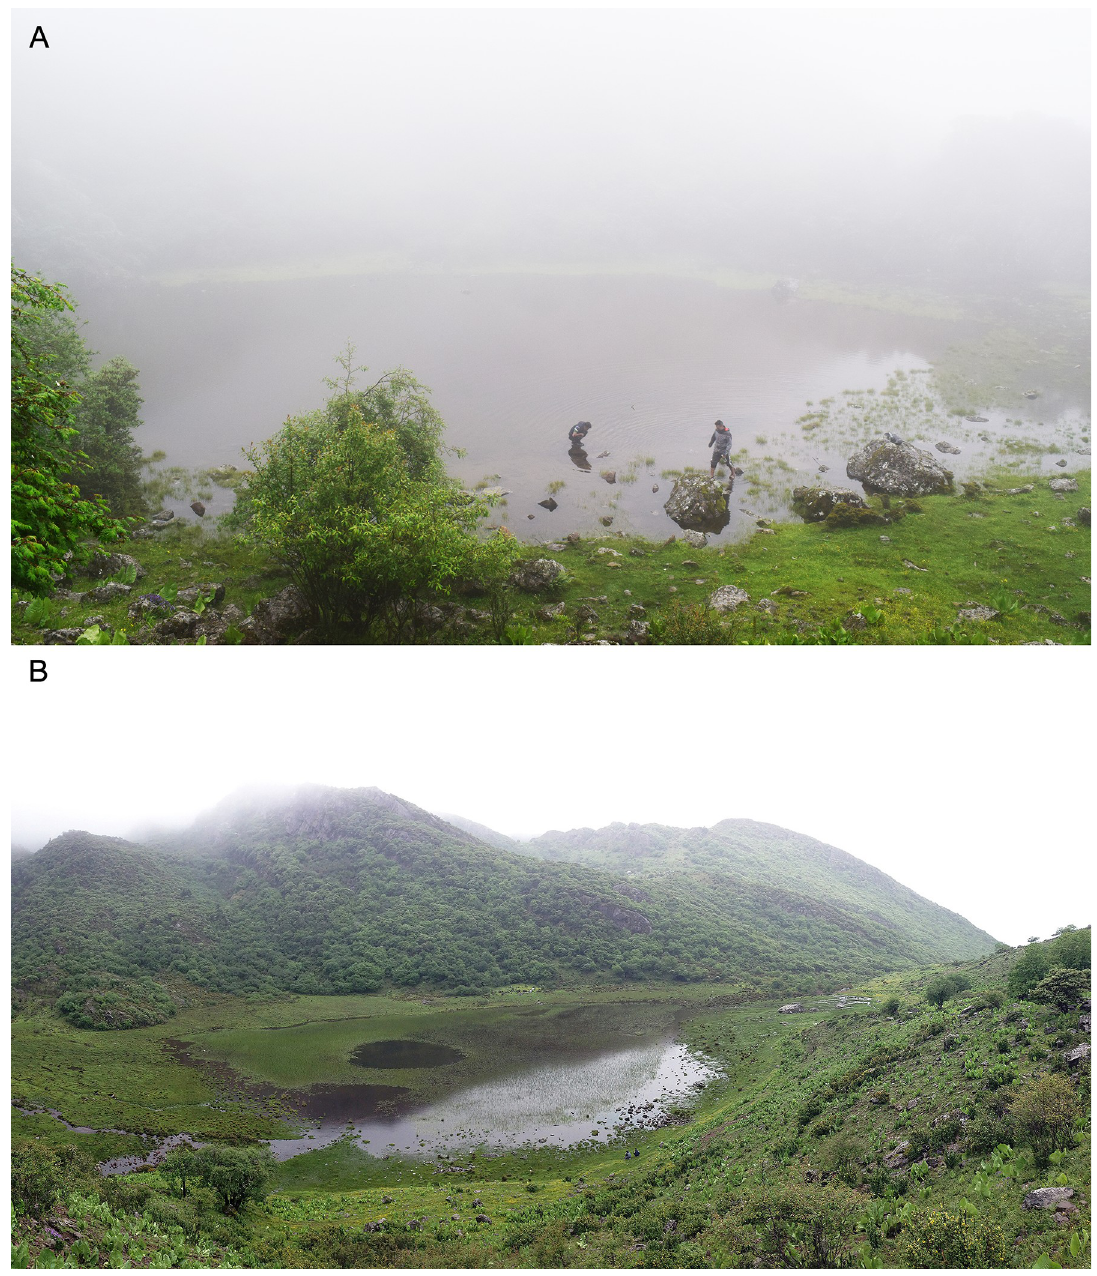
Fig 1. Photographs of the upper and lower ponds showing the high-altitude mountain pond and stream environments inhabited by Batrachuperus yenyuanensis at the type locality Shuangertang, near Yanyuan, Liangshan Yi Autonomous Prefecture, Sichuan Province, Southwest China. A, upper pond; B, lower pond (both looking to the west; photograph by J